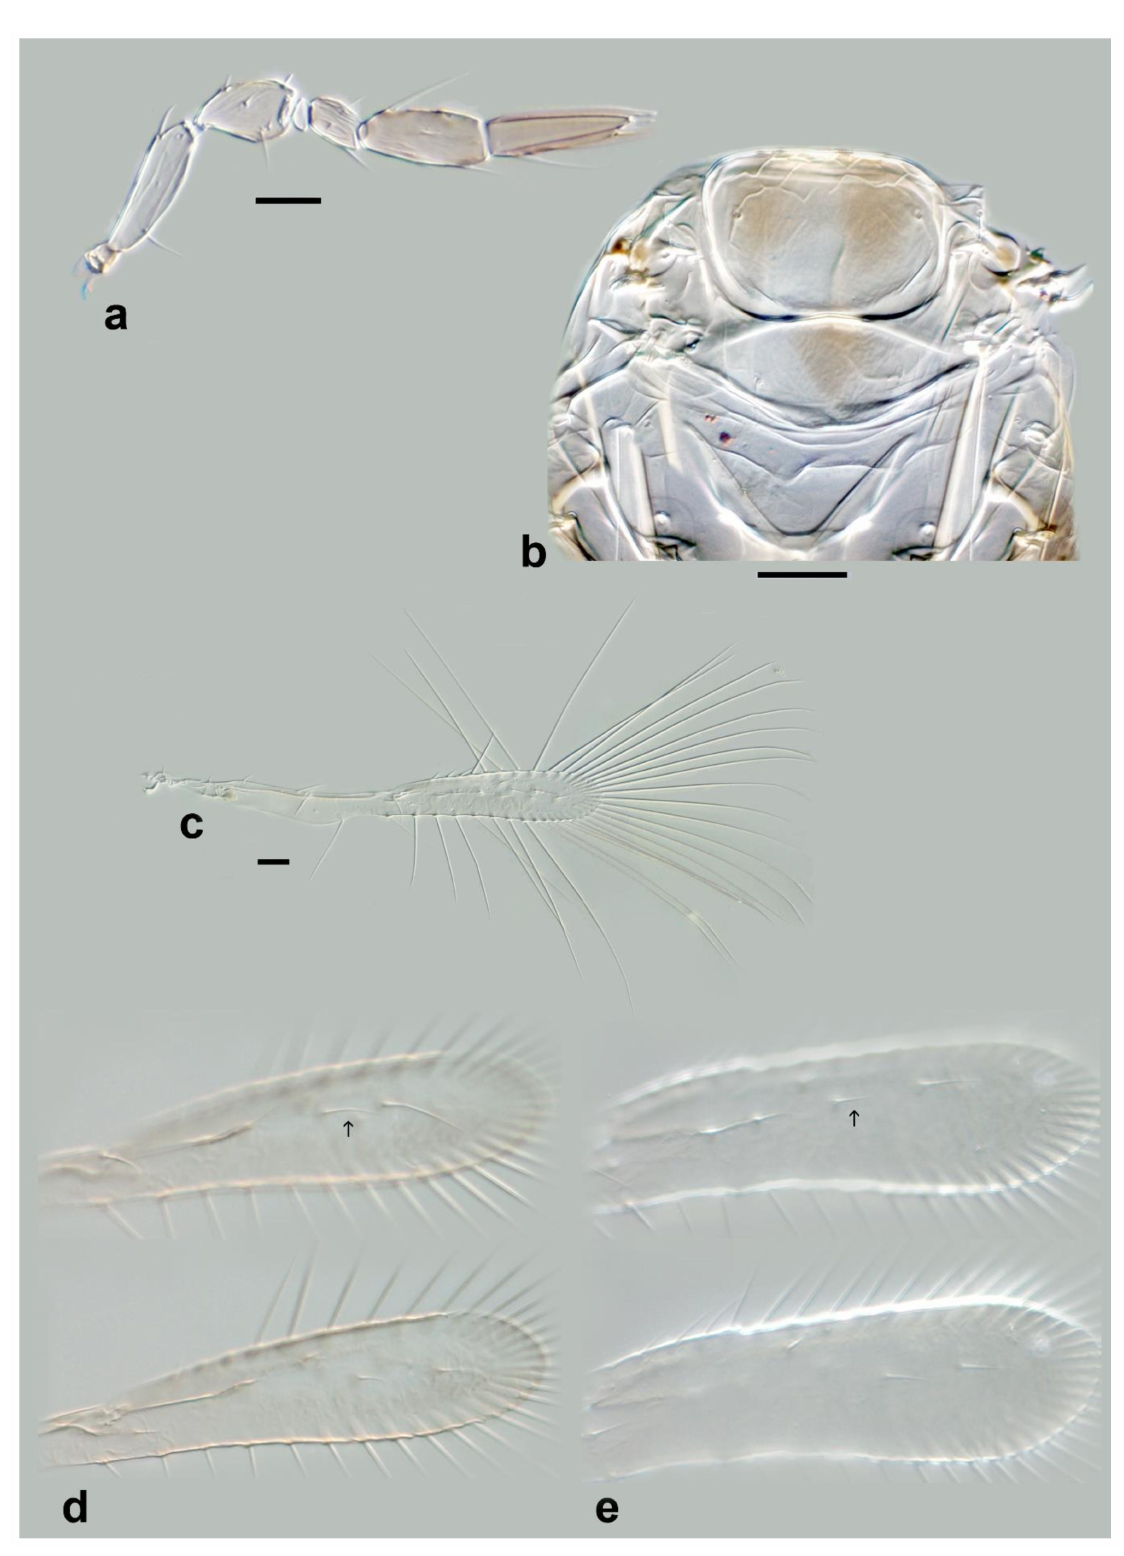
Figure 22. Photographs of Megaphragma species: ( a ) M. viggianii , female antenna (Holotype); ( b ) M. viggianii , female mesosoma (Holotype); ( c ) M. viggianii , female fore wing (Holotype); ( d ) M. viggianii , female ventral (above) and dorsal (below) wing surface, (Holotype); ( e ) M. priesneri , female ventral (above) and dorsal (below) wing surface (Neotype). Arrows point at the penultimate seta on ventral surface. Scale bars 20 µ